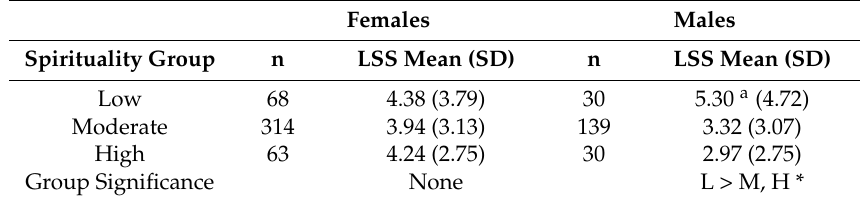
Table 3. Differences among Differentially Spiritual Groups of Females and